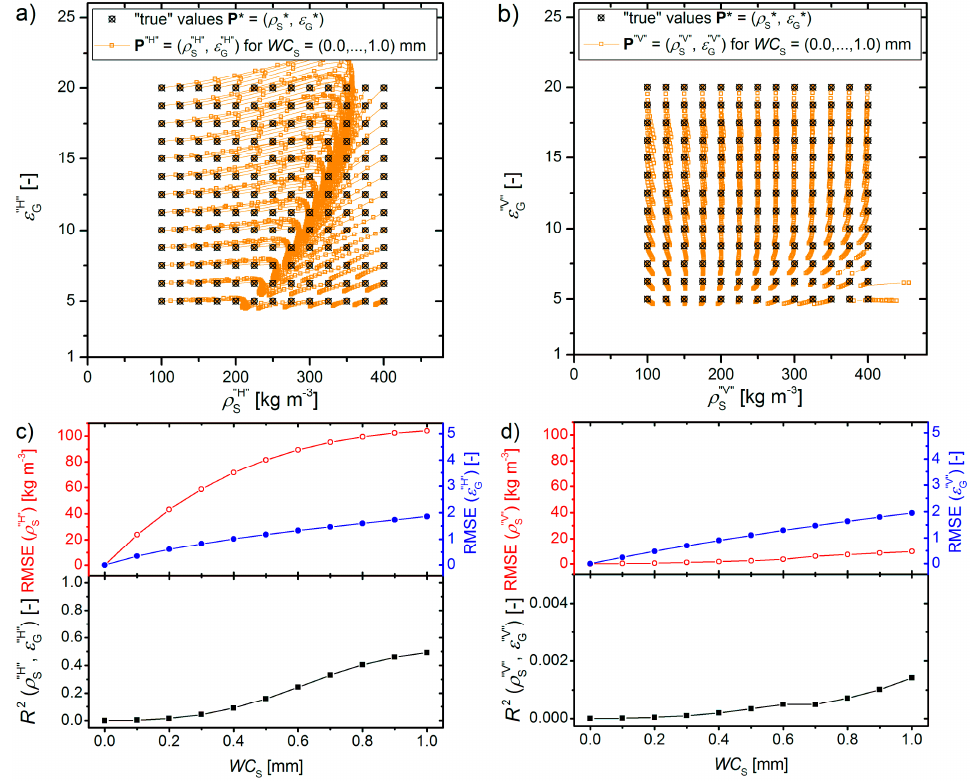
(cid:0) (cid:1) ρ RM , ε RM (orange squares) for RM = “H” (panel ( a )) S G